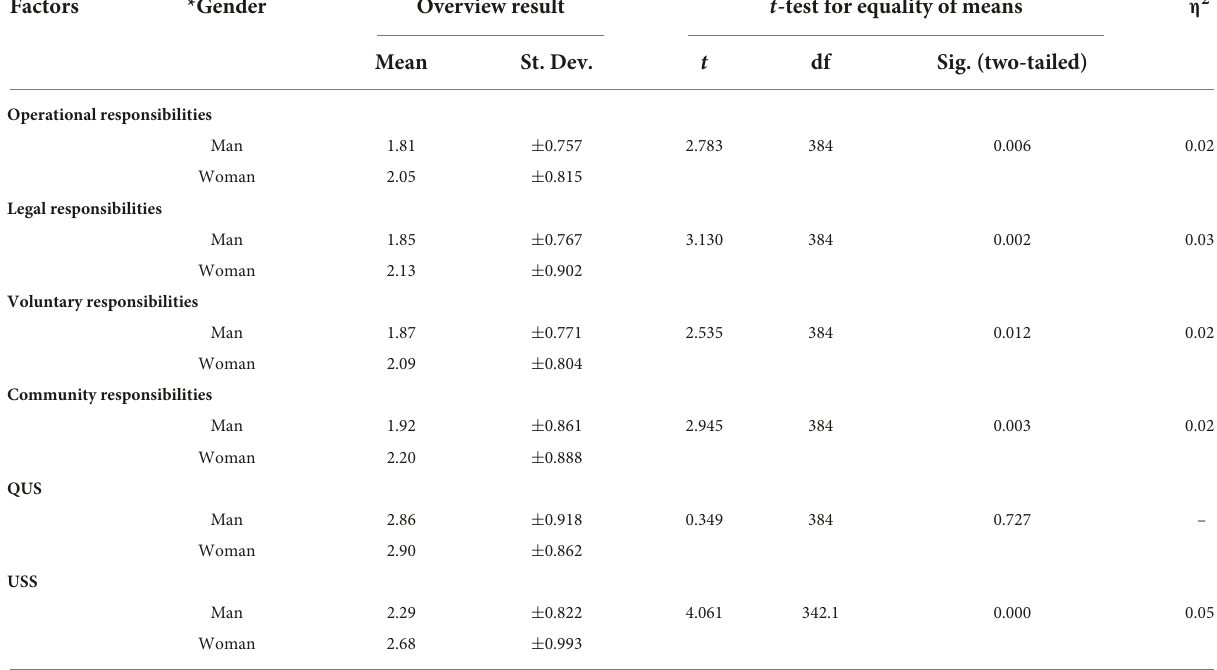
TABLE 3 Gender comparison for the factors of USR, QUS, and USS. Factors